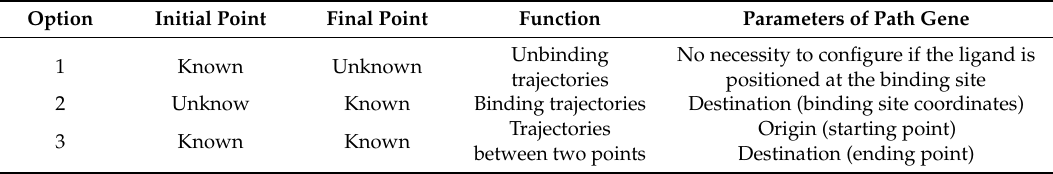
Table 4. Summary of available options to configure direction of the pathways in GPathFinder.